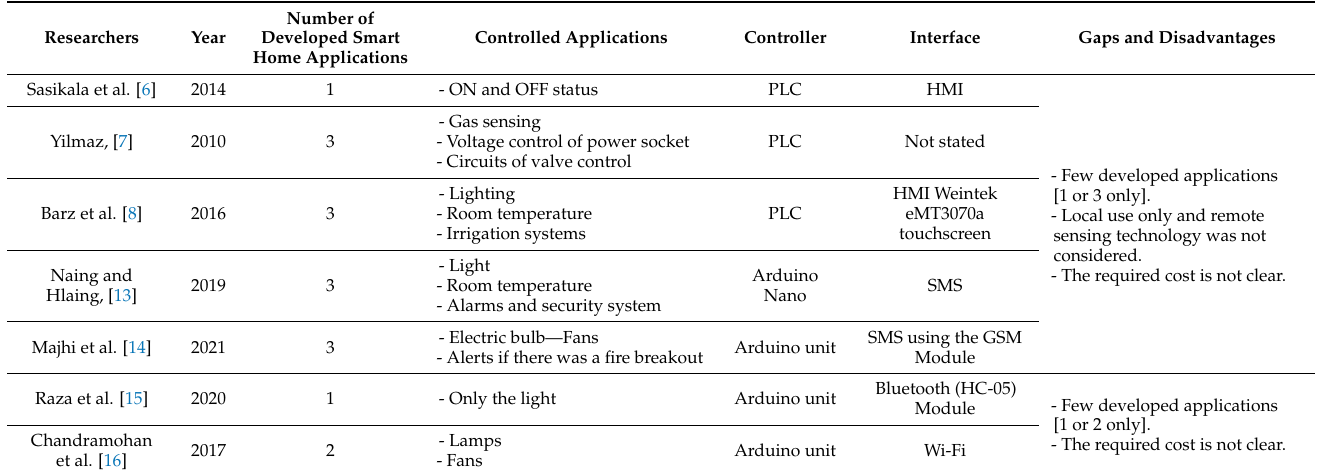
Table 1. The comparison between some developed smart home applications stated in